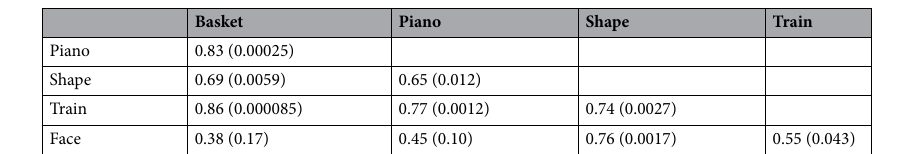
Table 3. Performances on the five games were correlated. Each value indicates the Spearman correlation and the corresponding P value (in parenthesis) between maximum levels reached in a pair of games.